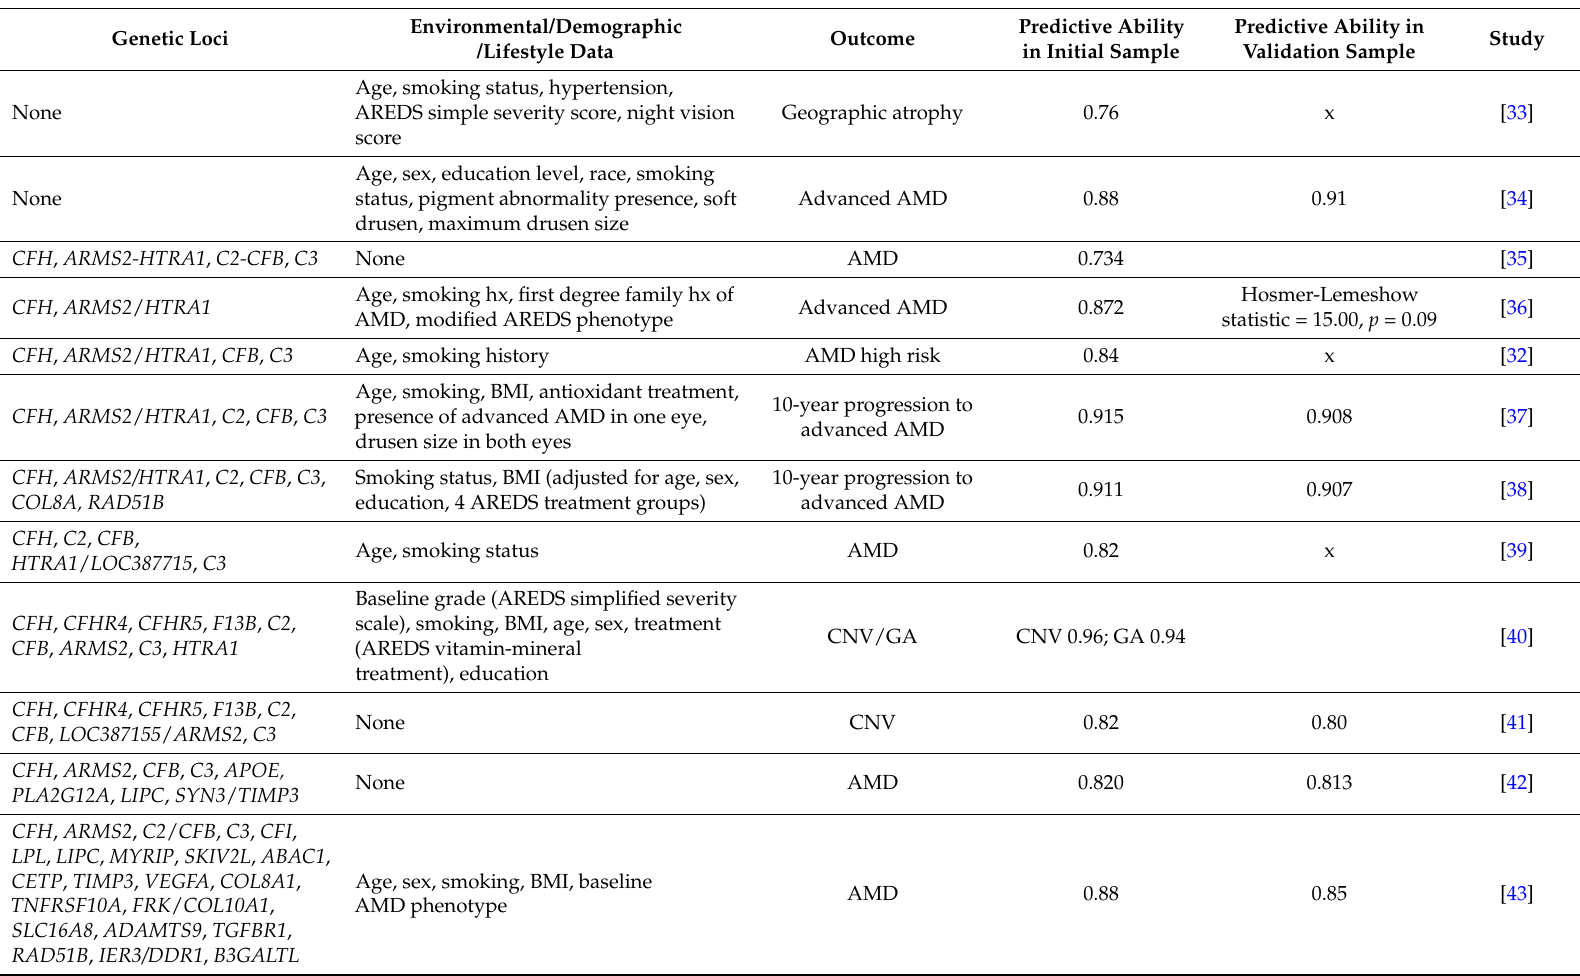
Table 1. Review of genetic risk scores to predict age-related macular